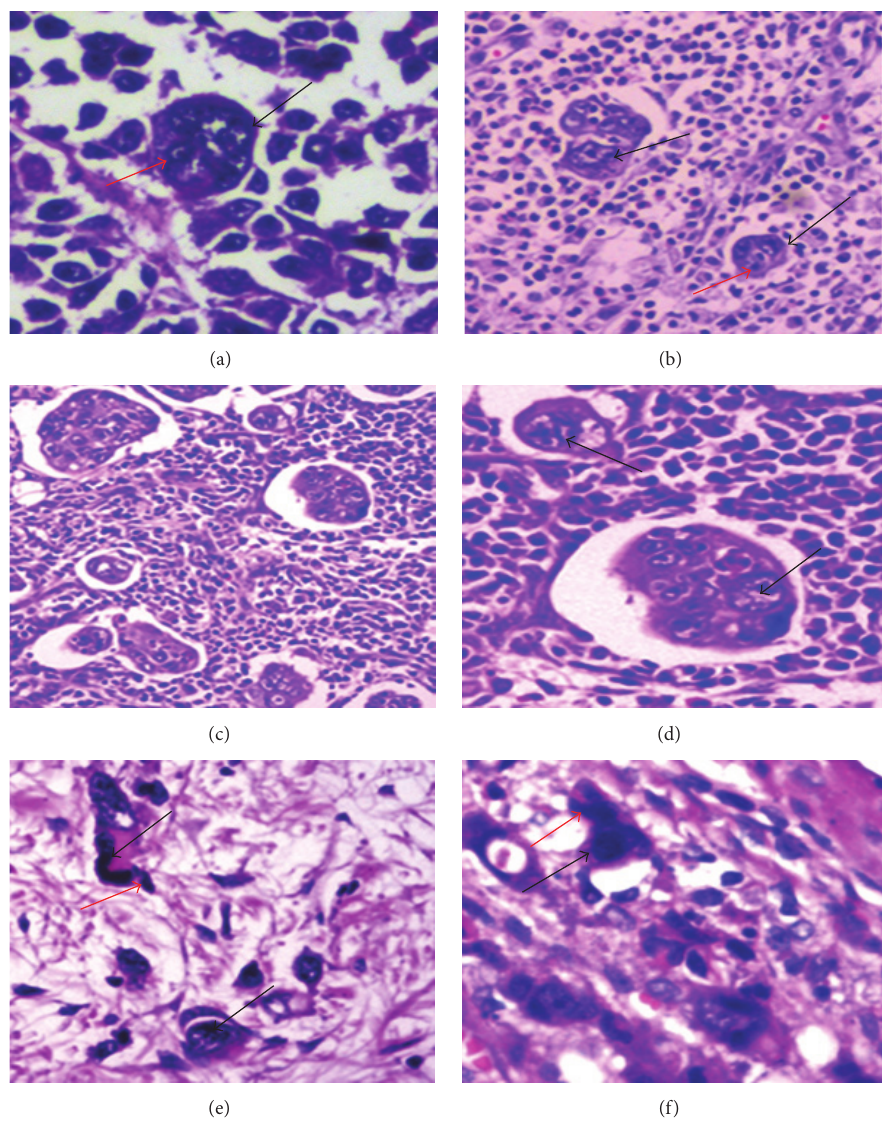
Figure 1: Tumor budding, PGCCs, and micropapillary carcinoma pattern in CRCs. ((a) and (b)) PGCCs with budding appear in minimally differentiated CRCs. Black arrows indicate PGCCs and red arrows indicate daughter cells generated by PGCCs (HE, × 200). (c) Micropapillary patterns appear in minimally differentiated CRC (HE, × 100). (d) PGCCs appear in micropapillary patterns (HE, × 100, black arrows). ((e) and (f)) Single PGCCs with their budding daughter cells in CRCs; and the structure is similar to tumor budding. Black arrows indicate PGCCs and red arrows indicate daughter cells budded by PGCCs (HE, ×